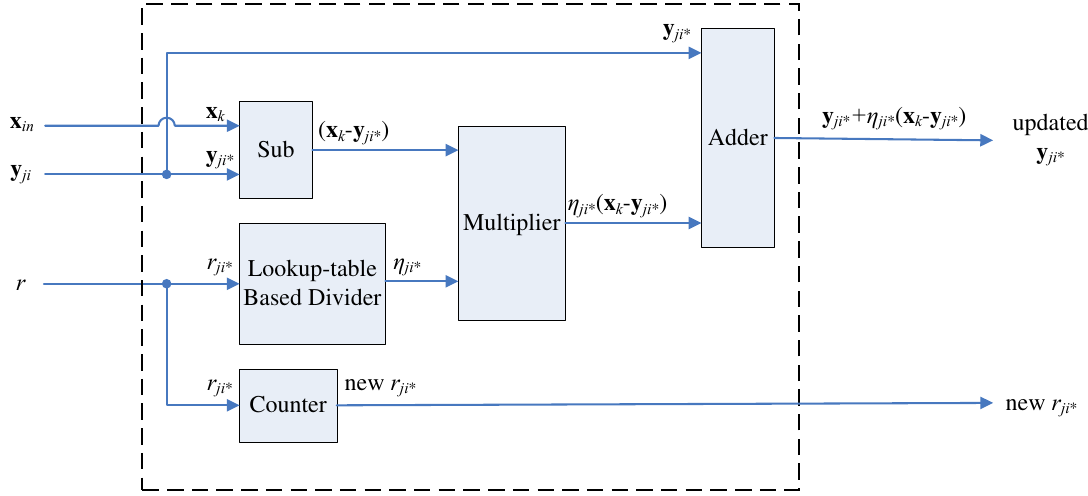
Figure 14. The architecture of the weight vector update